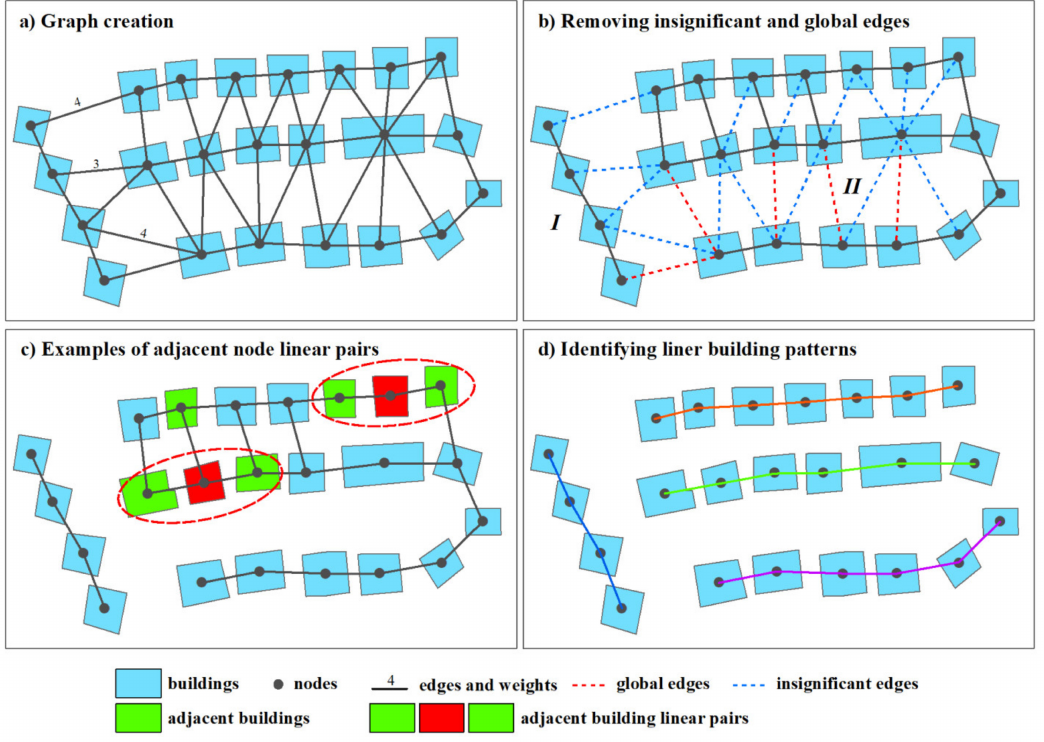
Figure 5. Methodological step 4 to step 6 is shown for ( a ) graph creation; ( b ) removing insignificant and global edges; ( c ) adjacent node linear pairs; ( d ) the final linear building